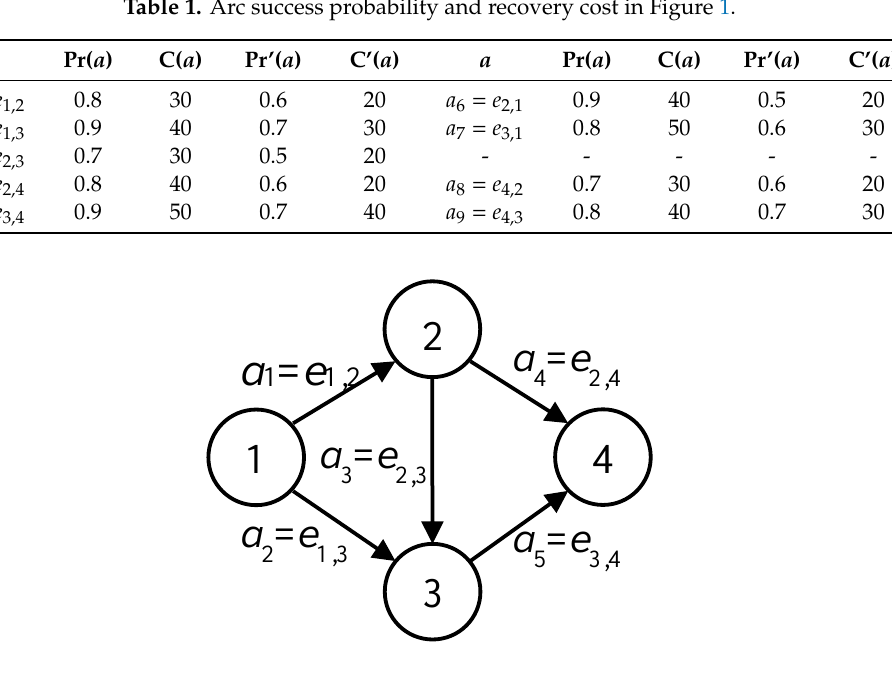
Figure 2. G ( X ) and X = (1, 1, 1, 1, 1, 0, 0, 0, 0) in Figure 1 [18].